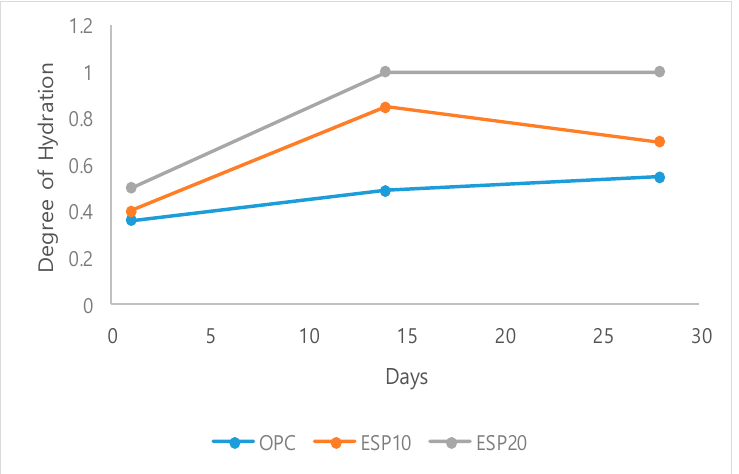
Figure 10. Degree of hydration.